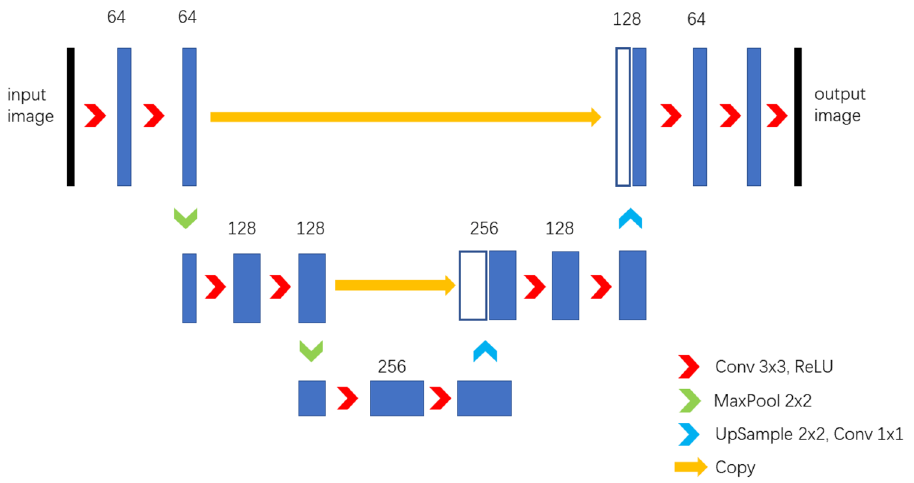
Figure 4. U-net structure in our